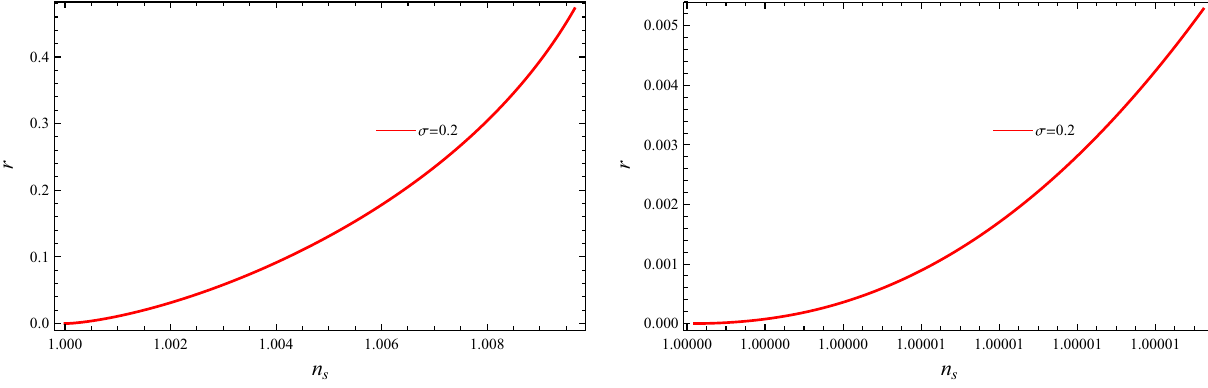
Fig. 10 Plot of r versus n s for MCG model in weak (left panel) and strong (right panel) dissipative regimes for negative potential with n = 1